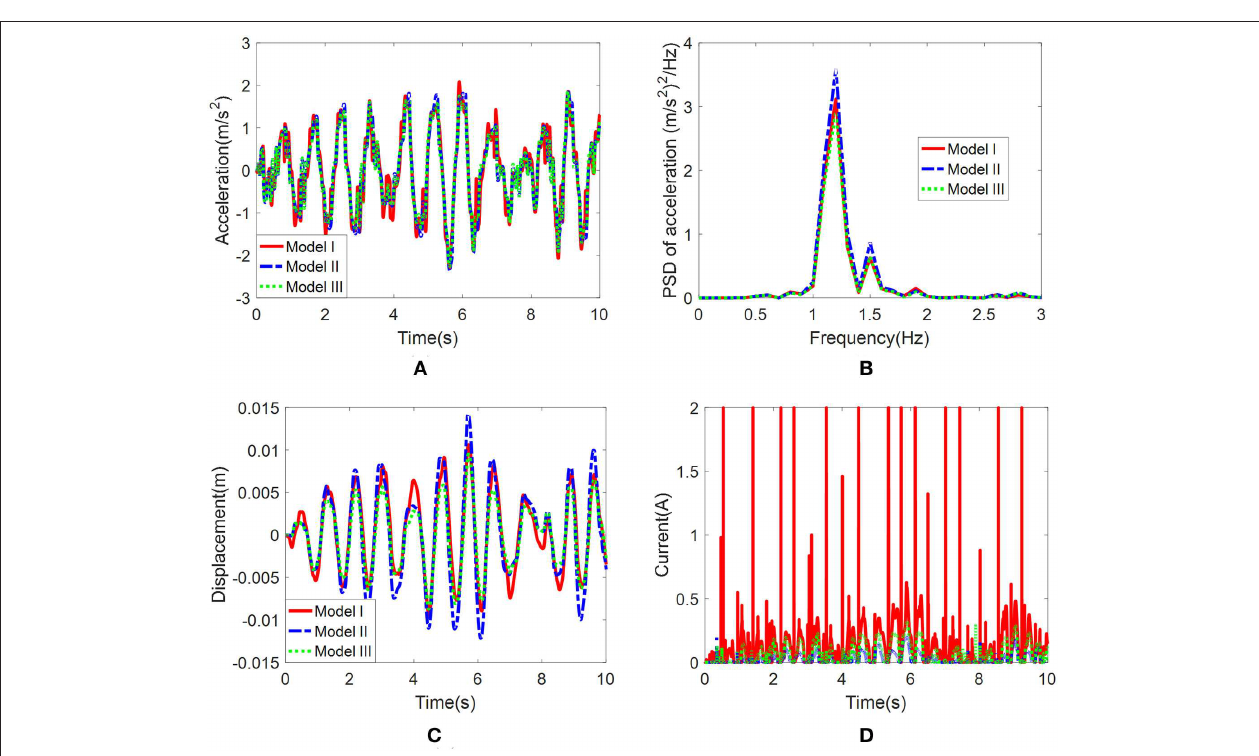
FIGURE 13 | Control performances of semi-active system with different models under temperature of 80 ◦ C. (A) Time domain of acceleration response. (B) Frequency domain of acceleration response. (C) Time domain of displacement response. (D) Applied current.